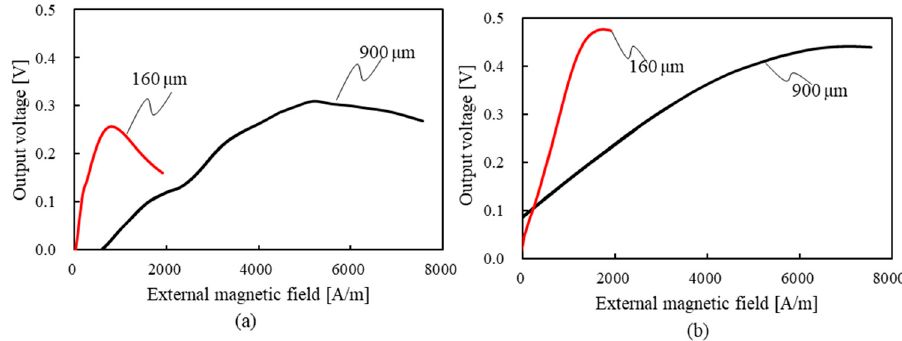
Figure 12. Measured values of the relationship between the external magnetic field and the output voltage: ( a ) rise-time output voltage; ( b ) fall-time output voltage.